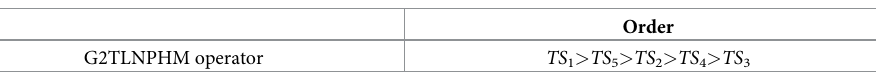
Table 4. Order for five alternatives.